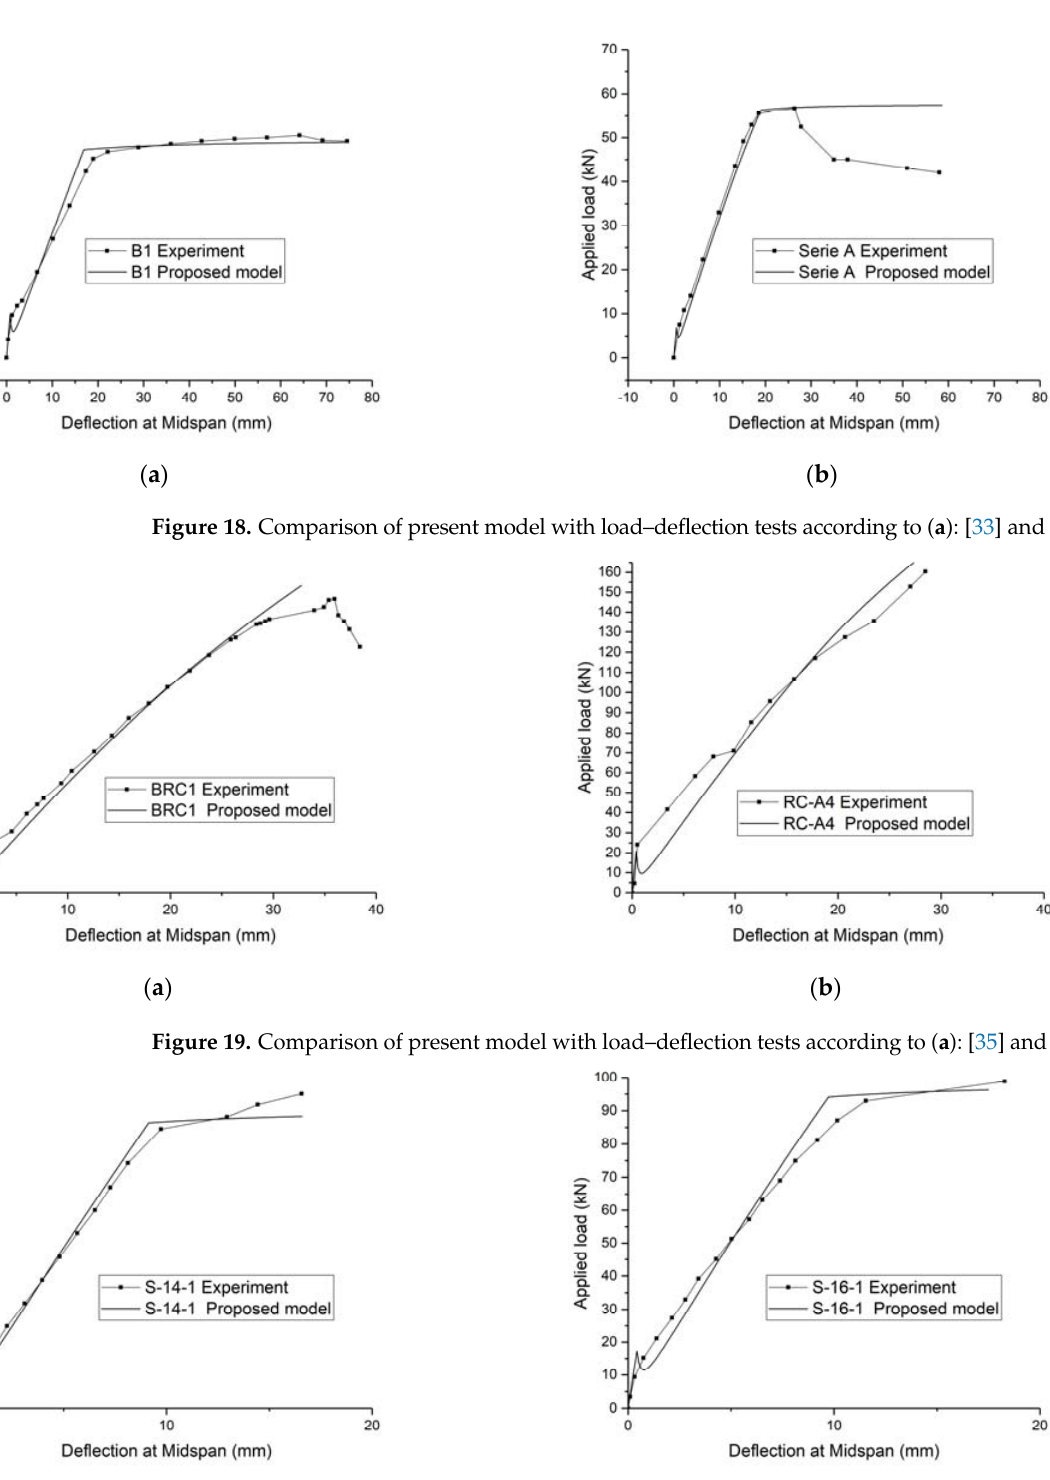
Figure 20. Comparison of present model with load–deflection tests according to [37].